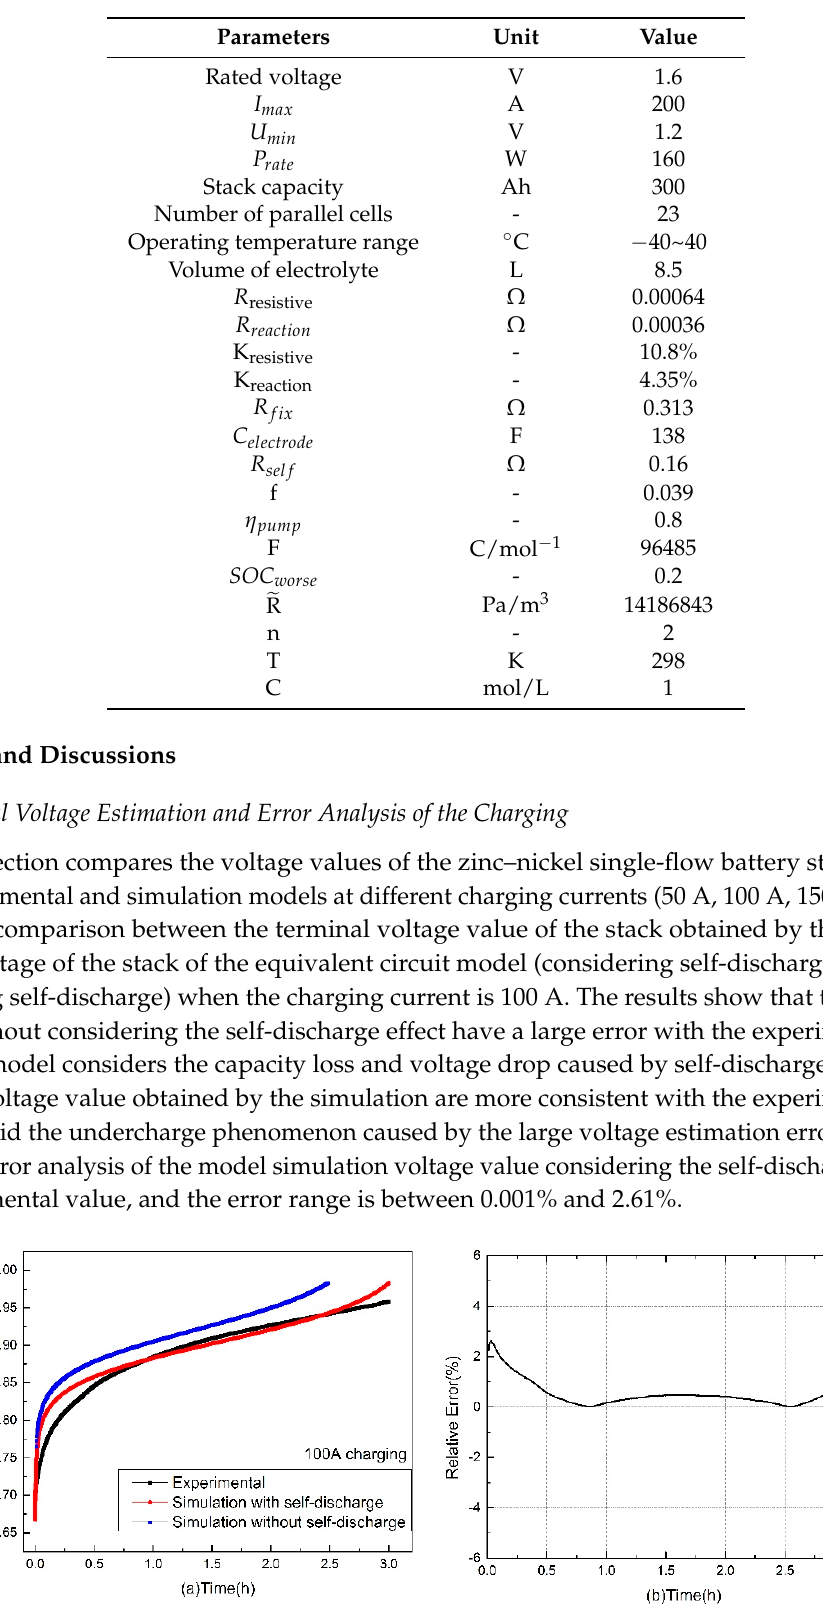
Table 3. Parameters [29–34].